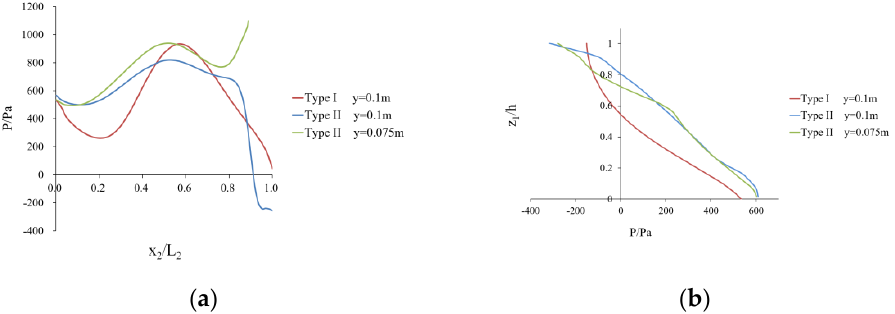
Figure 9. Pressure distribution on the horizontal and vertical surfaces of the step: ( a ) horizontal surface pressure distribution graph; ( b ) vertical surface pressure distribution diagram.